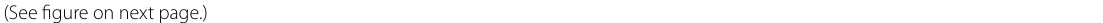
(See figure on next Fig. 2 Tri-plot of redundancy analyses (RDA) showing existing relationships between soil properties, sites, treatments and understory plant communities. Panel a represents taxonomic groups and plots that are grouped by treatments based on soil properties contributing significantly to the model. Panel b represents the ordination of plots that are grouped by sites based on soil properties contributing significantly to the model. Sample treatments are indicated by symbols (CON: control; SIN: single-tree selection cut; GRP: group-selection cut; GRPS: group-selection cut with scarification), explanatory variables by arrows. Percentage variance explained along each axis corresponds to R 2